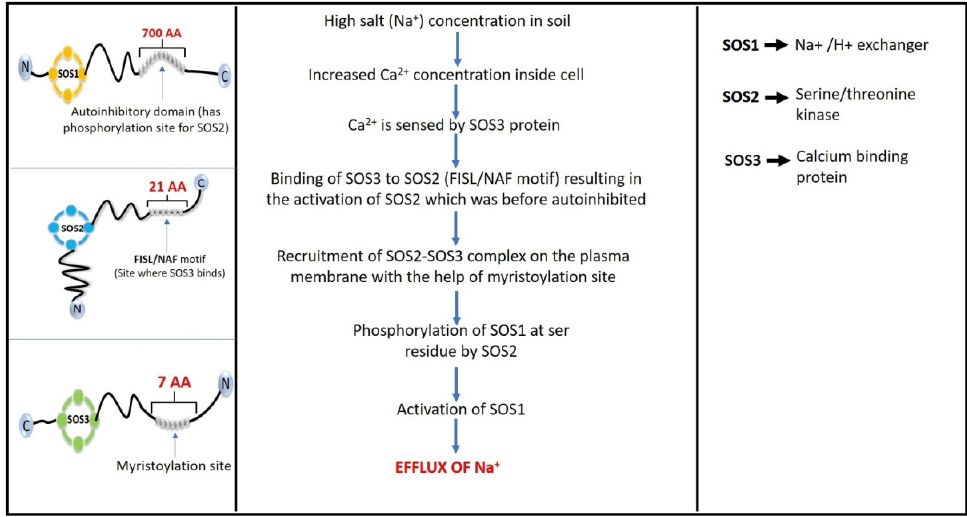
Figure 2. SOS proteins involved in SOS pathway which is primarily activated during salinity stress. The SOS1 is auto-inhibited in normal conditions when there are no hypersaline conditions. This auto-inhibition is only relieved when the SOS2 protein adds a phosphate group to the Ser1044 residue in the C-terminal region of SOS1, which occurs when the plant is under salinity stress [146]. The SOS2 gene is responsible for producing a ser- ine/threonine kinase enzyme [147]. The FISL/NAF motif, which comprises 21 amino ac- ids, is found in the regulatory region of SOS2 at the C-terminus, while the catalytic do- main is found at the N-terminus, showing sequence homology with sucrose nonfer- menting (SNF) kinases [148]. The interaction of the regulatory domain containing the FISL motif with the catalytic domain of SOS2 causes auto-inhibition in normal conditions.